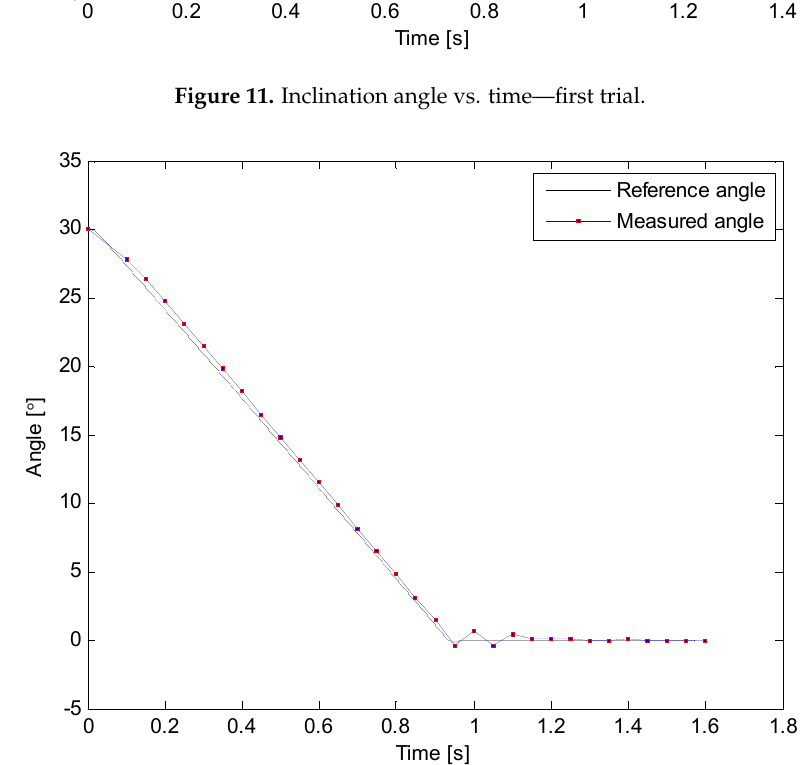
Figure 12. Inclination angle vs. time—second trial.